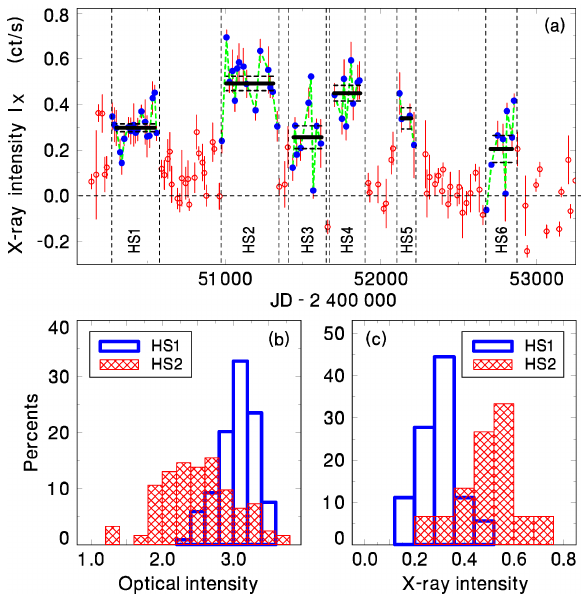
Figure 3: (a) Part of the ASM/ RXTE (1.5–12 keV) [12] light curve of AM Her (15-d means). The mean lev- els and their standard errors are marked. (b, c) Intensi- ties of the optical (AFOEV data, the intensity I = 1 for 14.3 mag) and hard X-ray (1.5–12 keV) (ASM/ RXTE data) emissions in two consecutive episodes of the high state. A higher luminosity of the hard X-ray emission may not be always accompanied by a higher optical emission in a given